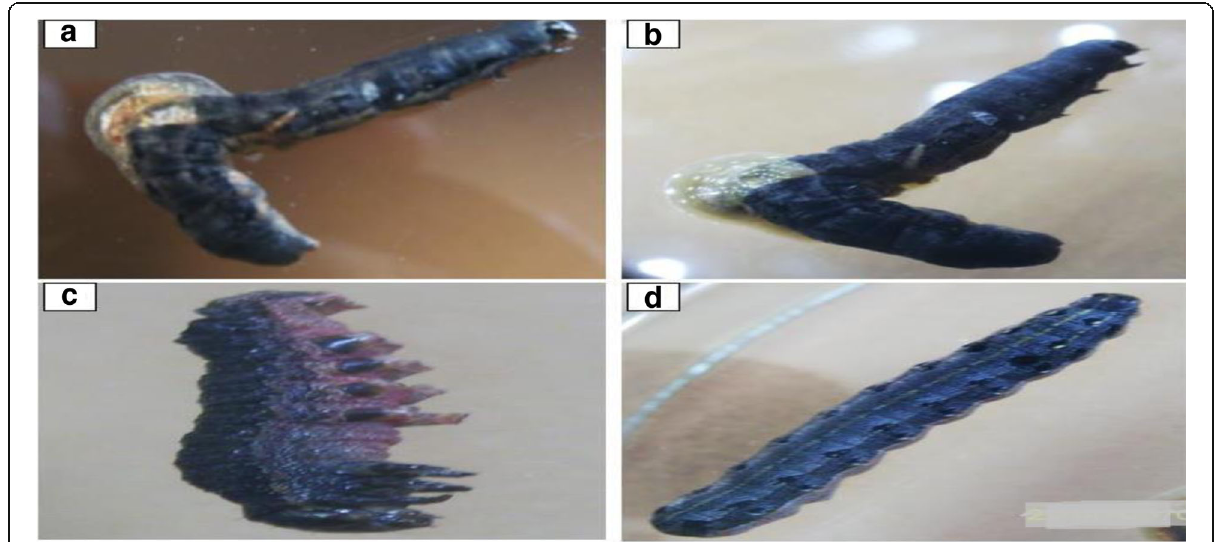
Fig. 1 Malformation caused by spirotetramat ( a , b ) and spiromesifen ( c ) compared to untreated larvae ( d )